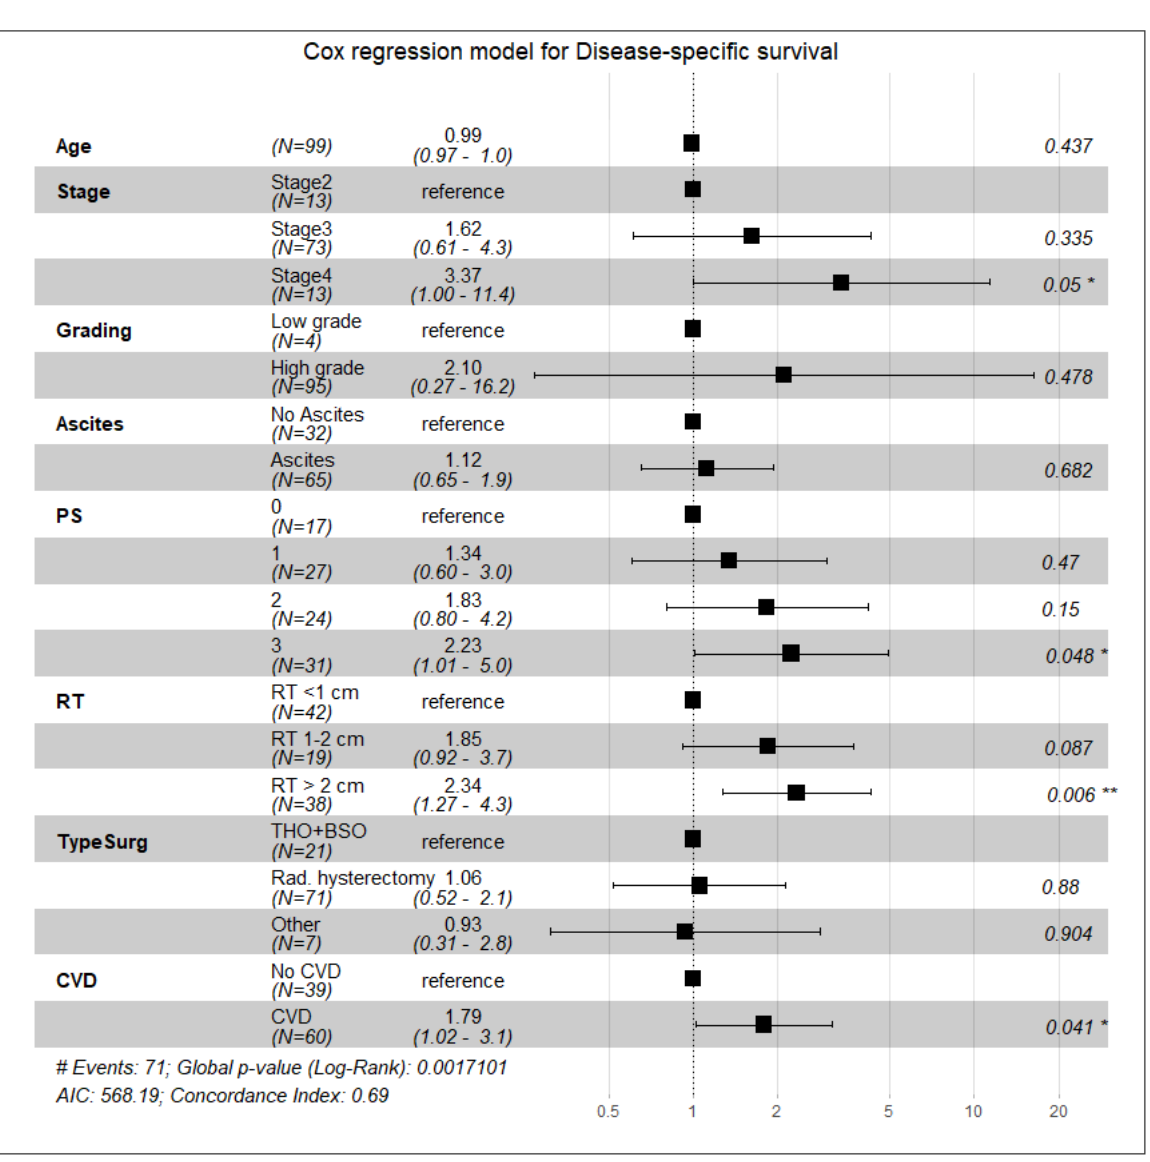
Figure 3. Forest plot. Cox regression multivariate analysis of the influence of various variables and cardiovascular diseases on disease-specific survival. Statistical power = 0.19. ( * p ≤ 0.05, ** p ≤ 0.01; # Events = number of events)